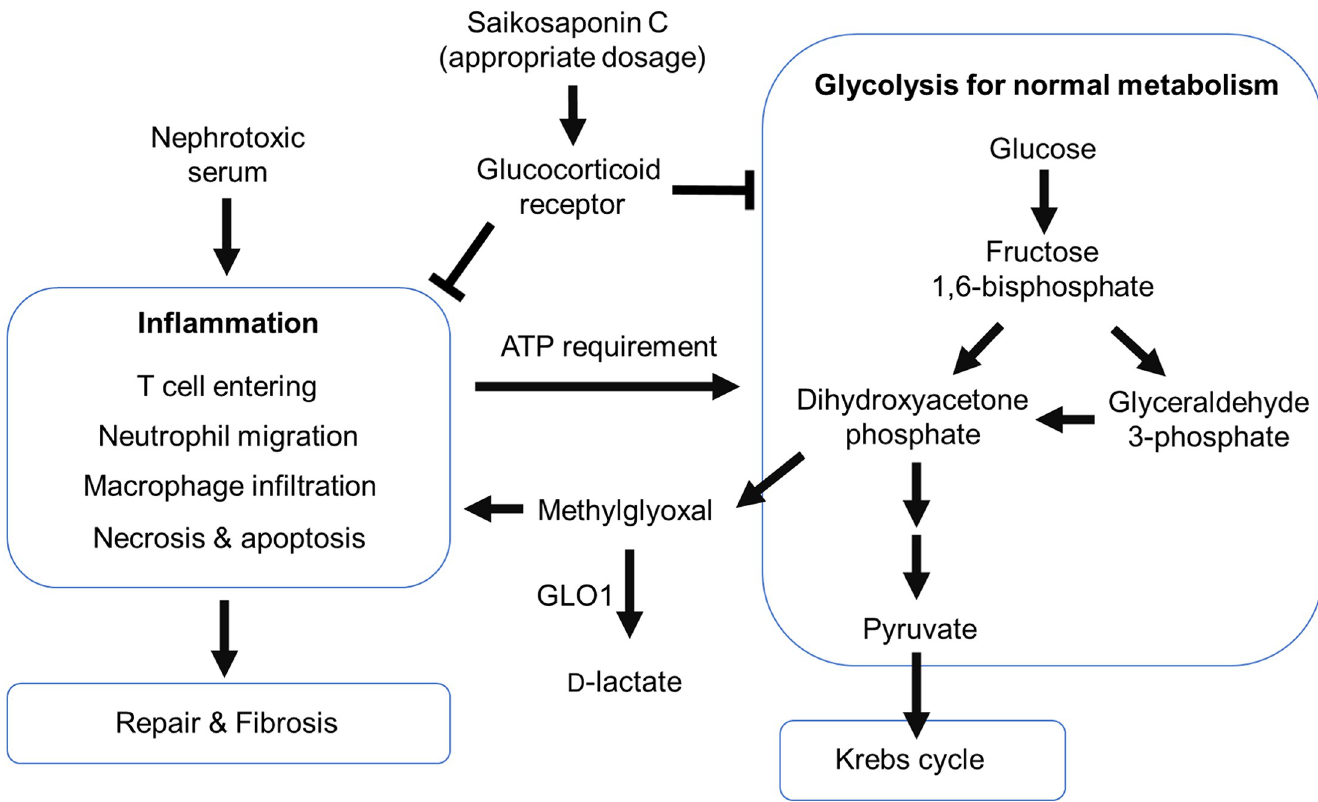
Fig 11. The relationship between methylglyoxal and D-lactate in saikosaponin C treatment of nephrotoxic serum nephritis. Nephrotoxic serum nephritis induced inflammation up-regulated glycolysis then cause methylglyoxal and D-lactate increased in the urine. The appropriate dosage of saikosaponin C treatment may improve the immune-reaction and down-regulate methylglyoxal and D-lactate